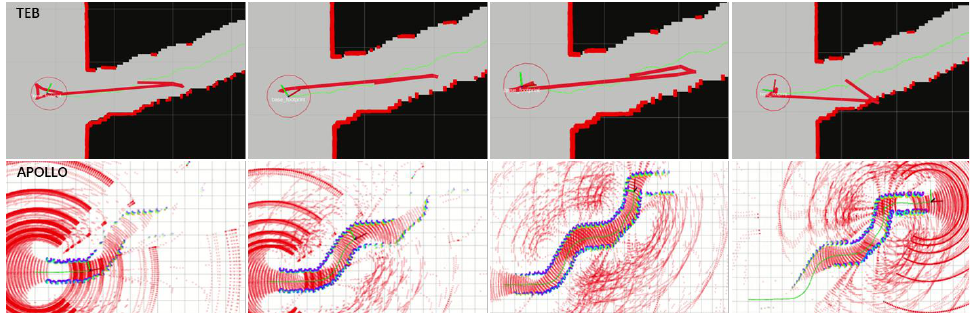
Figure 17. Illustration of the performance of the TEB algorithm and the APOLLO algorithm in the narrow channel scenario. For the TEB algorithm, the red line indicates the local trajectory and the green line indicates the global path. For the APOLLO algorithm, the blue dots represent the point cloud of the narrow channel.